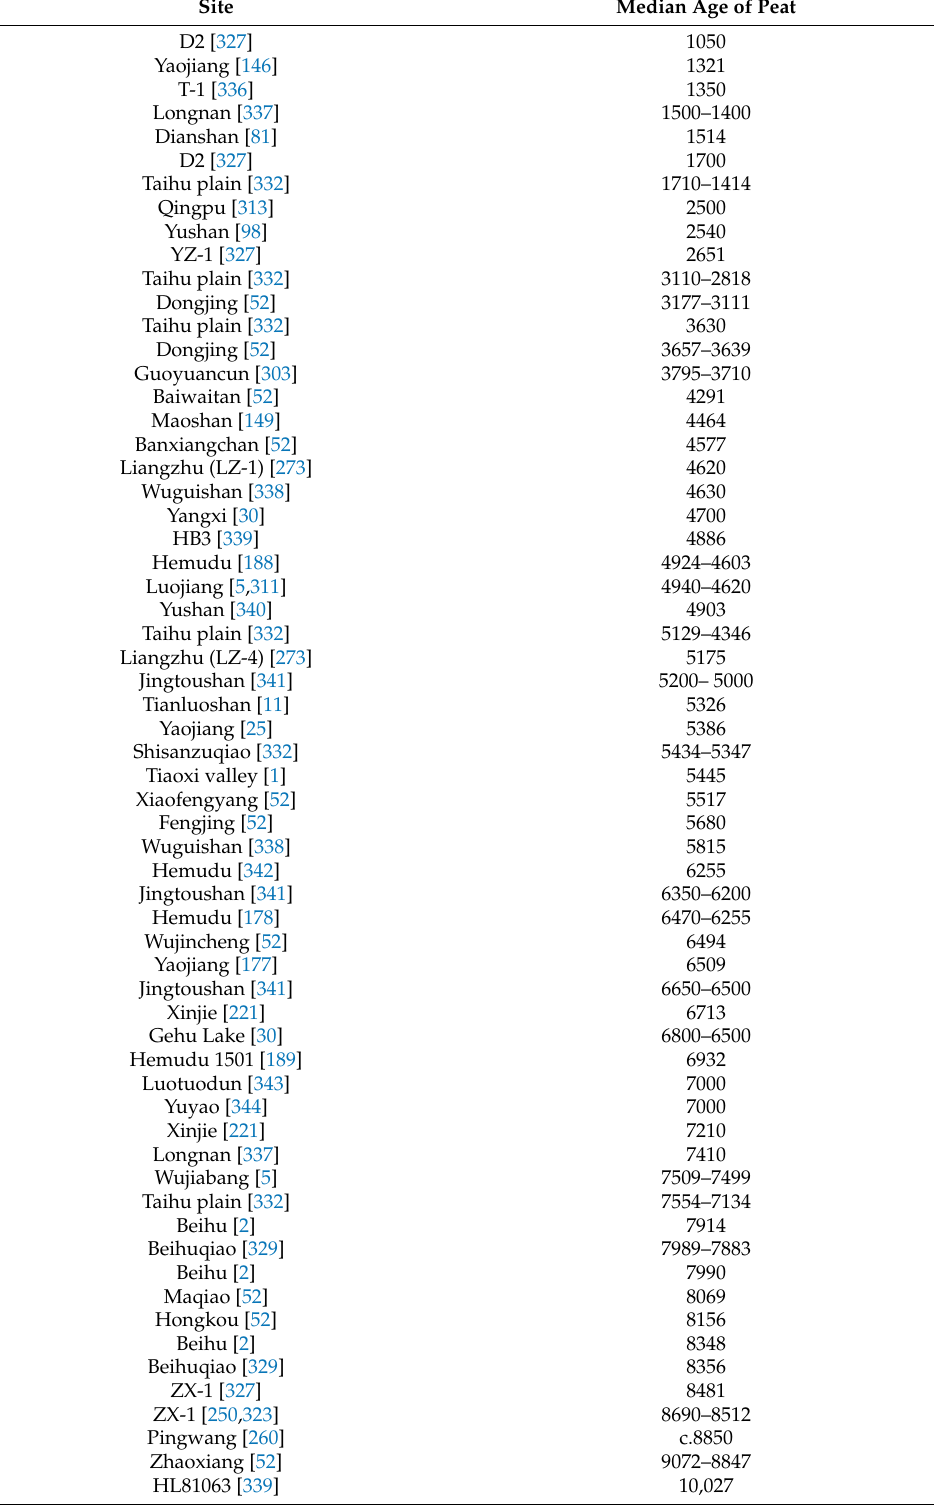
Table 2. Chronology of phases of Holocene peat formation (surface water table) in the Taihu low- land/lower Yangtze area. Dates are in calibrated years BP. Age ranges may include several